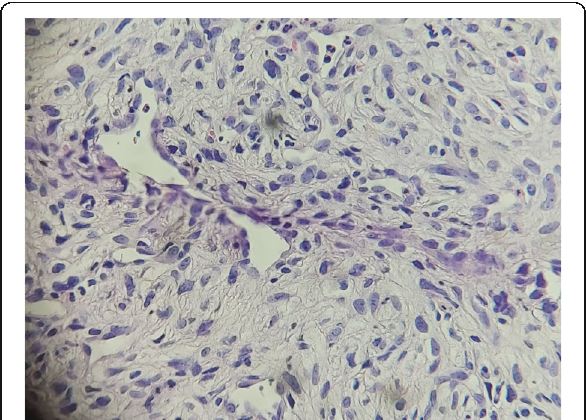
Fig. 4 Nuclear expression of 30% of tumor cells of the anti Ki67